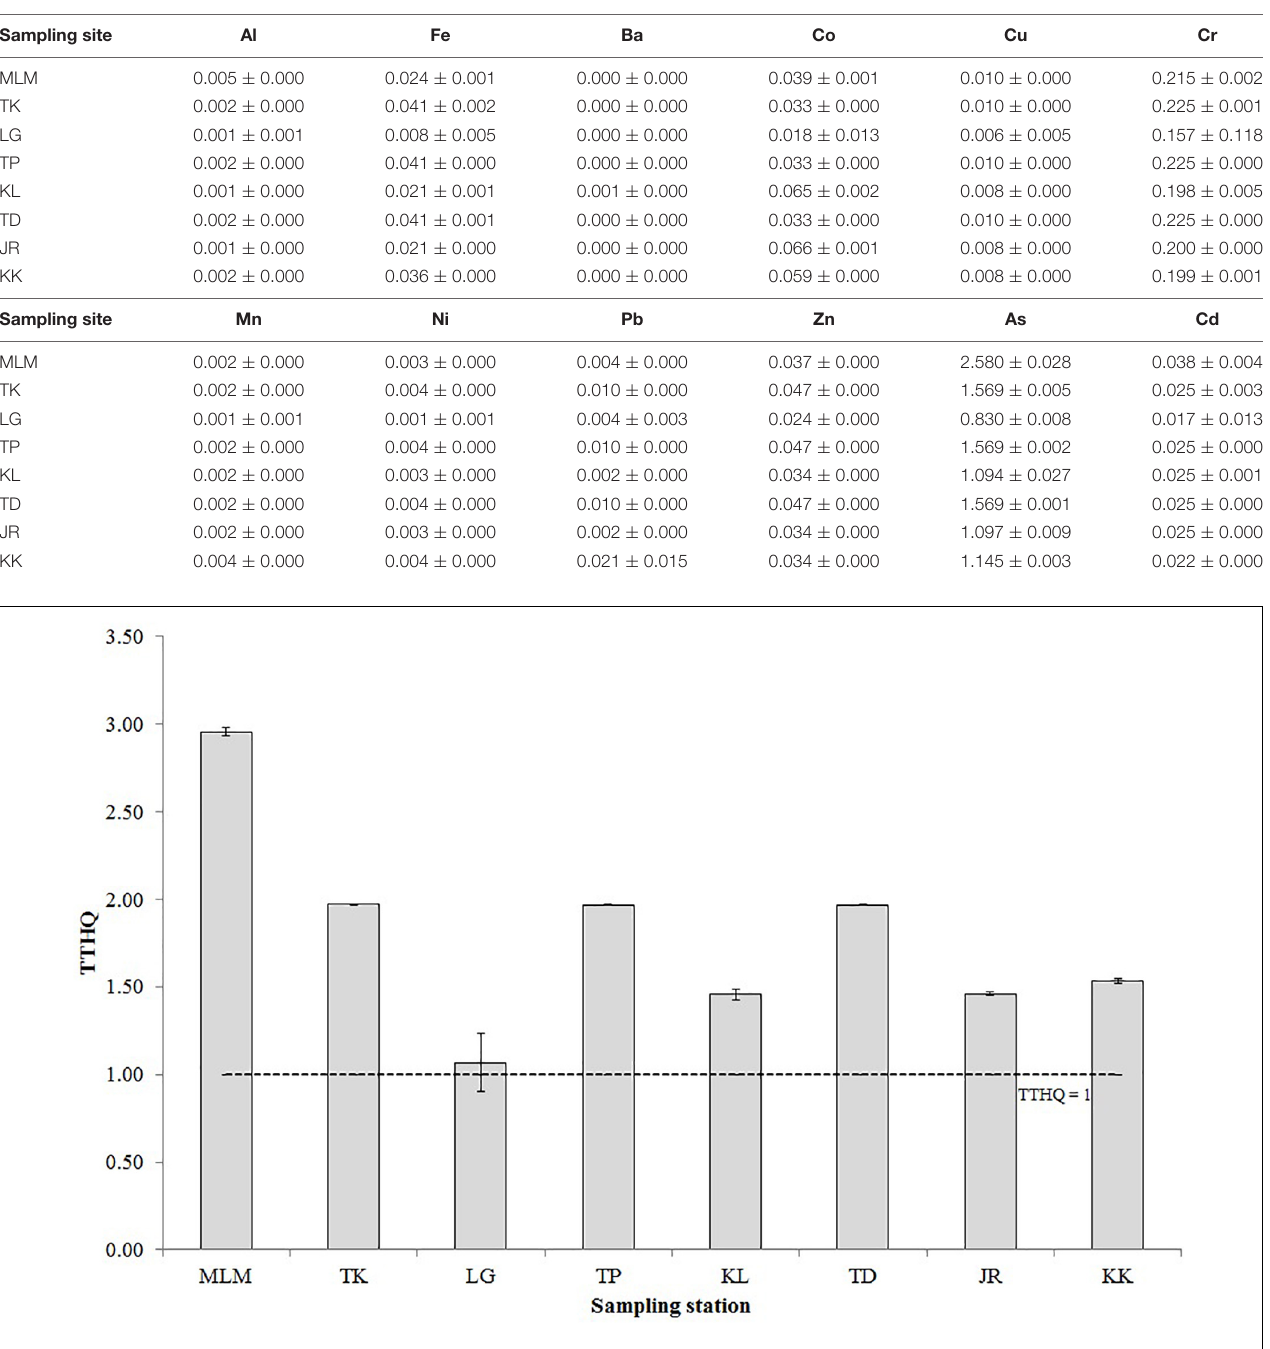
TABLE 5 | Target hazard quotient (THQ) of elements via the consumption of giant mudskippers collected from the West Coast of Peninsular Malaysia. Sampling site